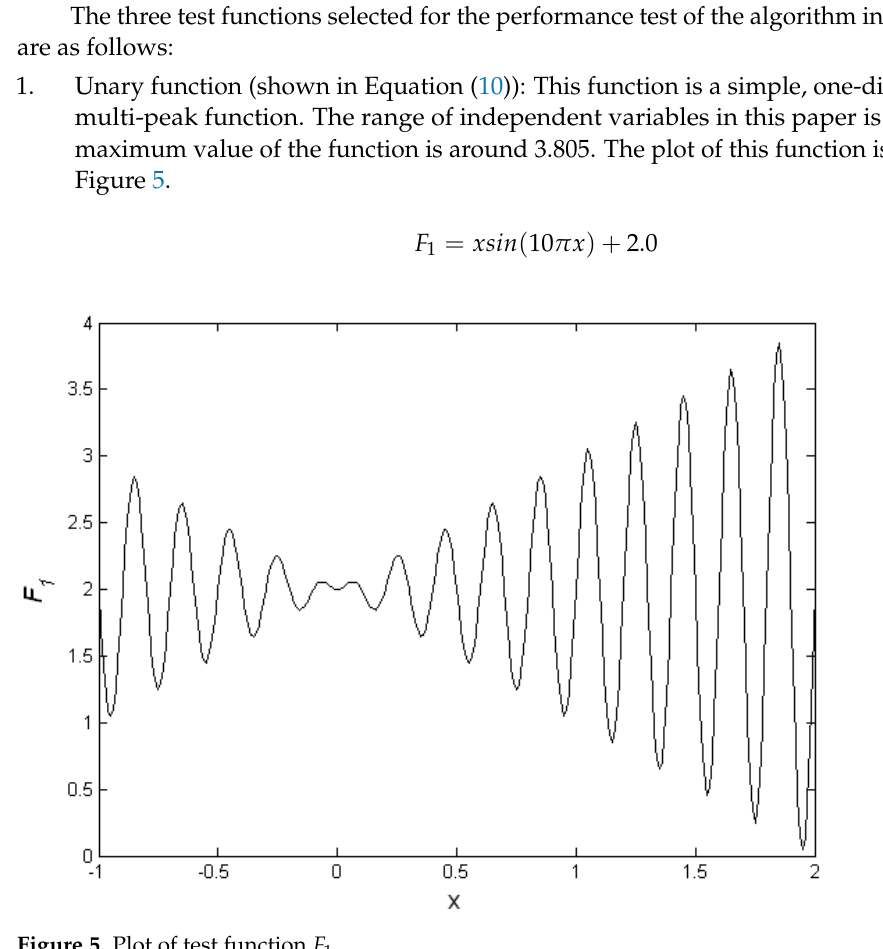
Figure 5. Plot of test function F 1